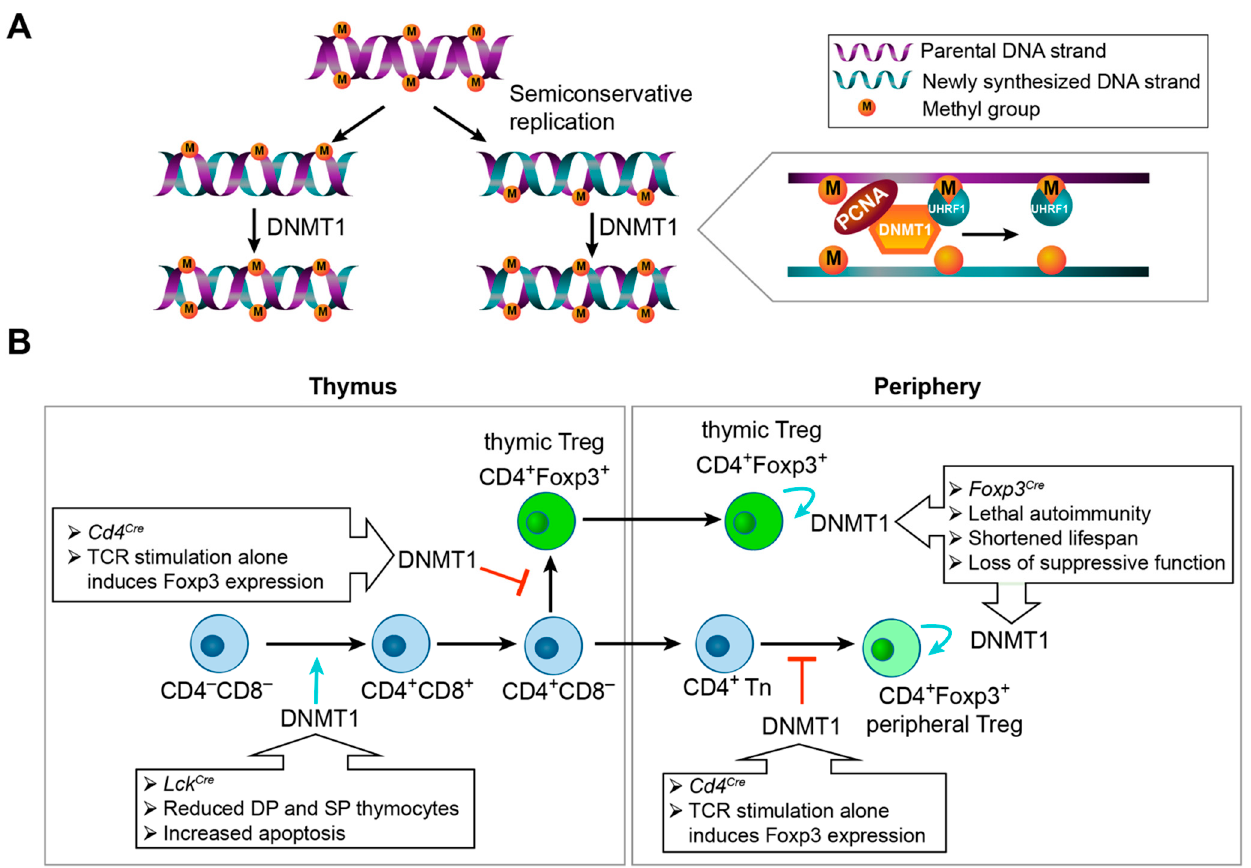
Figure 2. DNMT1 and the maintenance of DNA methylation patterns in Treg cell lineage specification and function. ( A ) Schematic of DNMT1 in maintaining preexisting DNA methylation patterns during semiconservative DNA replication and cell division. DNMT1 associates with PCNA and UHRF1 to bind to hemi-methylated DNA at the replication fork to methylate newly synthesized CpG sites. Impaired DNMT1 function would lead to DNA hypomethylation upon cell division. ( B ) Key effects of the conditional deletions of Dnmt1 by Lck Cre , Cd4 Cre , or Foxp3 Cre on the differentiation of precursor cells and Treg cells in